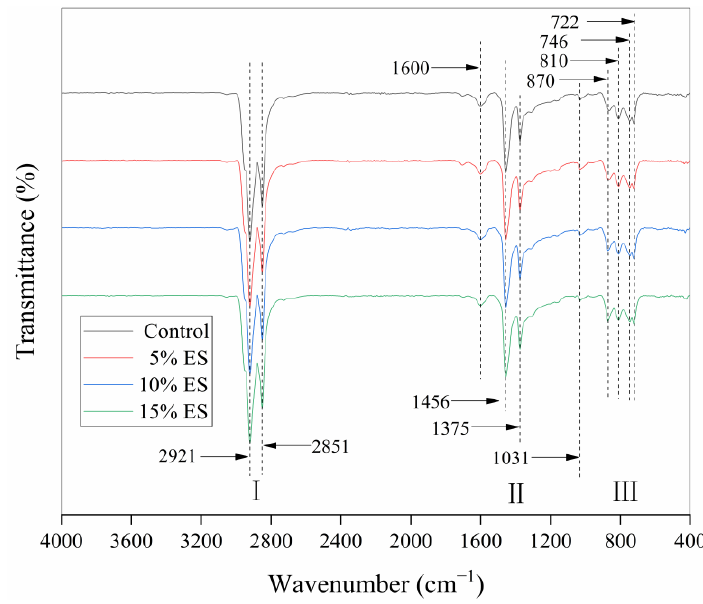
Figure 5. Infrared spectrum of asphalt binder.